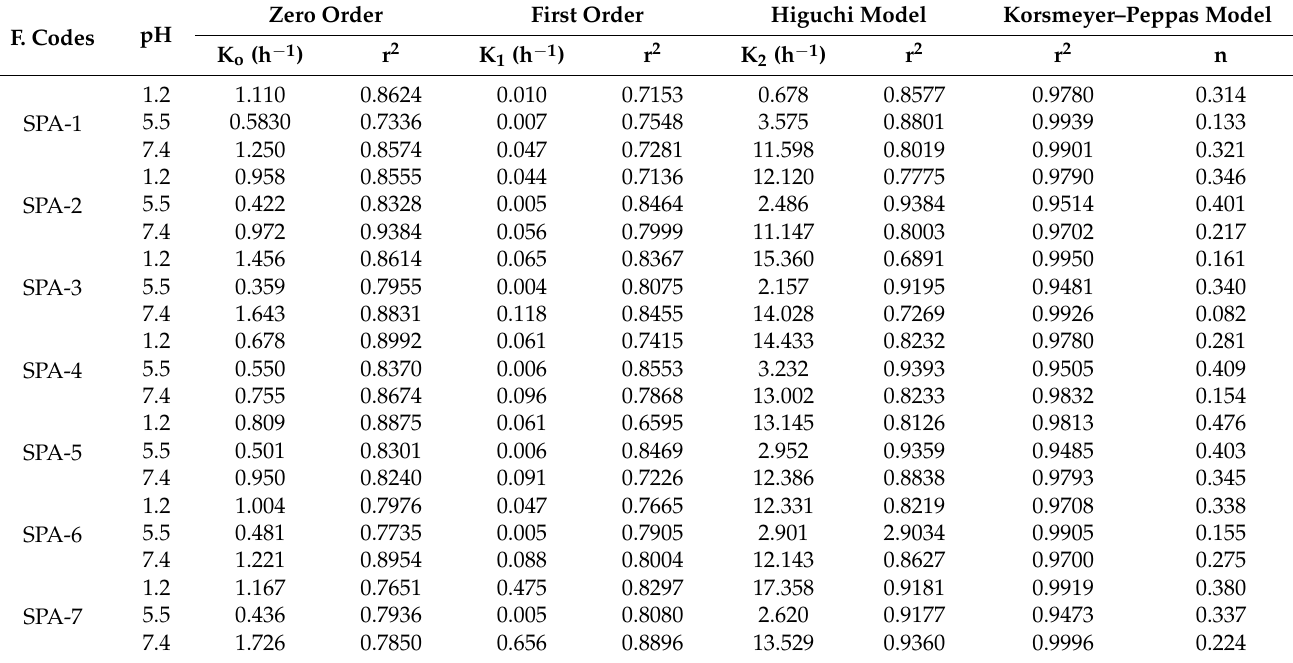
Table 1. Drug release kinetics of gallic acid-loaded sodium alginate (PVA-co-acrylic acid) hydrogel membranes.